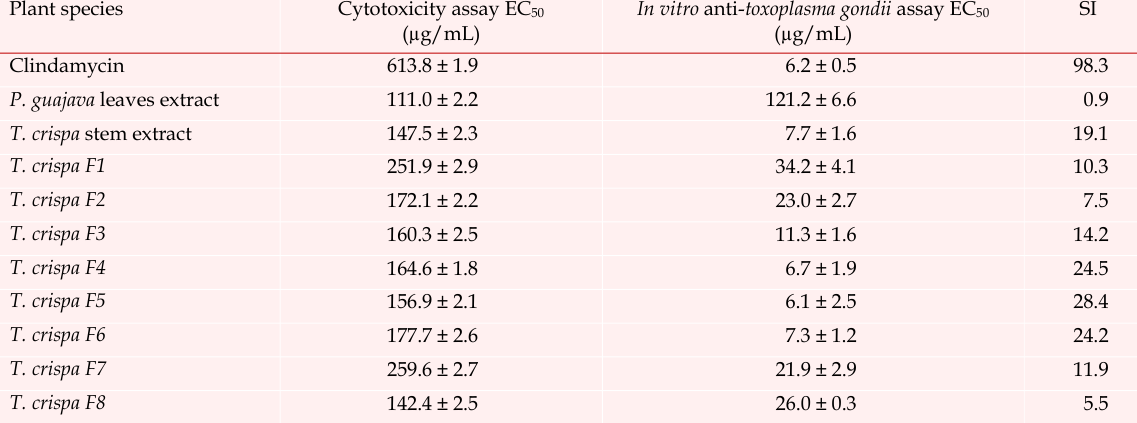
In vitro anti-parasitic activity of plant extracts and clindamycin on Toxoplasma gondii and cytotoxicity on vero Plant